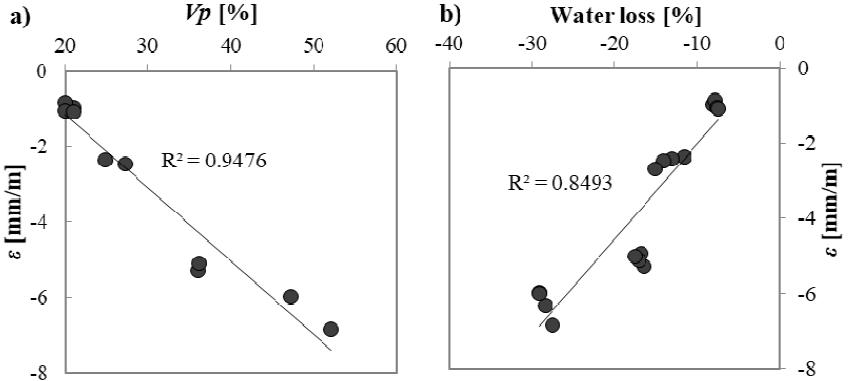
Figure 5. Correlation between ( a ) shrinkage and total porosity; ( b ) shrinkage and water loss of mortars.